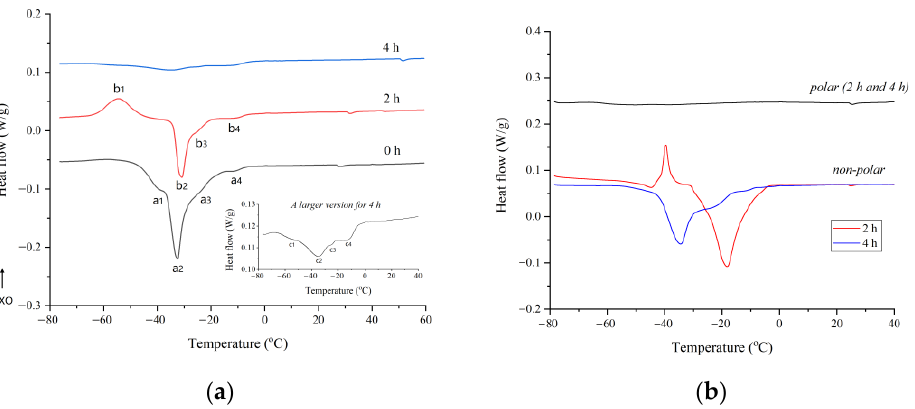
Figure 4. Heating thermograms of flaxseed oil and its fraction at different heating times: ( a ) flaxseed oil; ( b ) polar and nonpolar fraction of flaxseed oil. Note: the insert in Figure 4 a is an enlarged plot of melting curves of flaxseed oil heated for four hours.